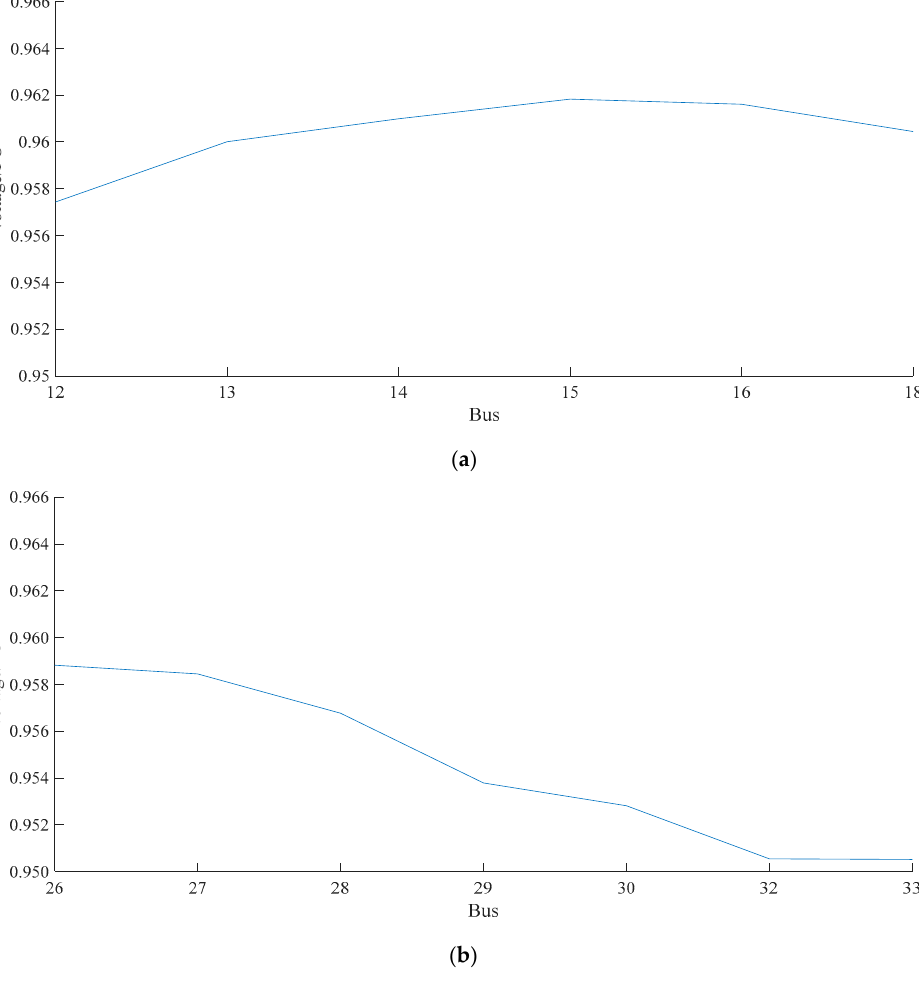
Figure 11. Voltage control effects of the remaining buses in ARs 3 and 5: ( a ) lowest voltage of each bus in AR 5 at all times and ( b ) lowest voltage of each bus in AR 3 at all times.